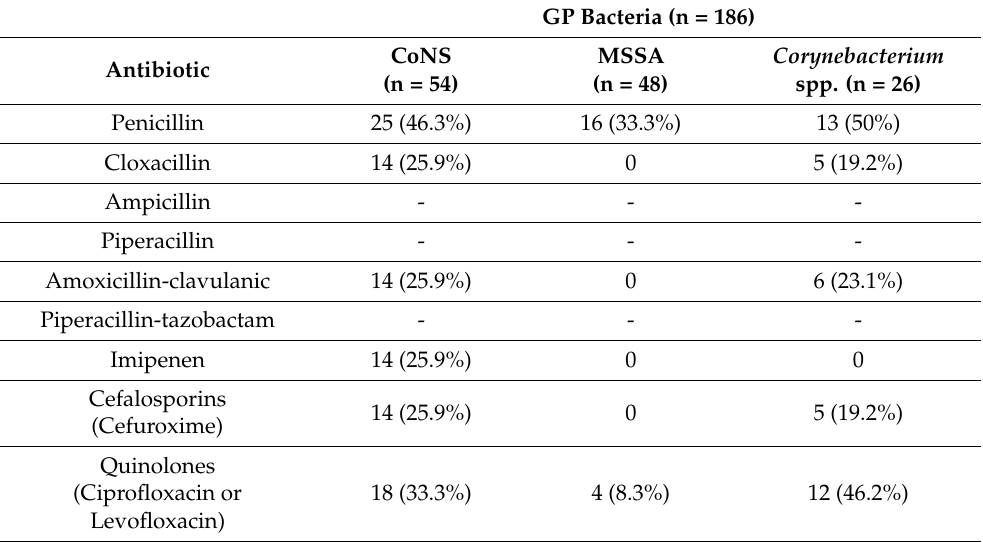
Table 3. Resistance analysis of common GP bacteria to sensitive